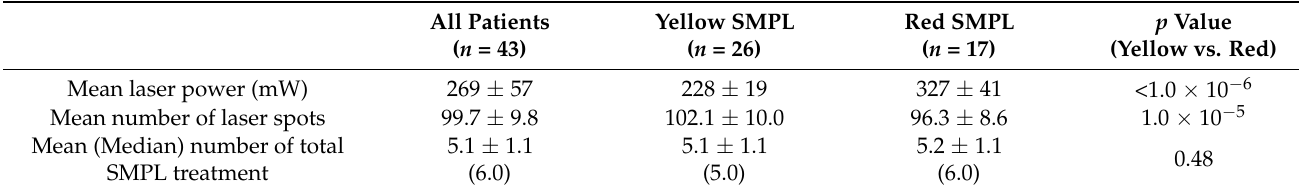
Table 4. Values of the parameters for the yellow and red subthreshold micropulse laser treatment during the 12 months of the follow-up period. p Value All Patients Yellow SMPL Red SMPL ( n = 43) ( n = 26) ( n = 17) (Yellow vs. Red) Mean laser power (mW) 269 ± 57 228 ± 19 327 ± 41 <1.0 × 10 − 6 Mean number of laser spots 99.7 ± 9.8 102.1 ± 10.0 96.3 ± 8.6 1.0 × 10 − 5 Mean (Median) number of total 5.1 ± 1.1 SMPL treatment